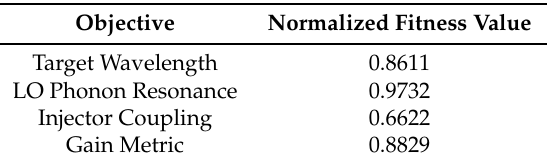
Table 4. Initial population best candidate design fitness